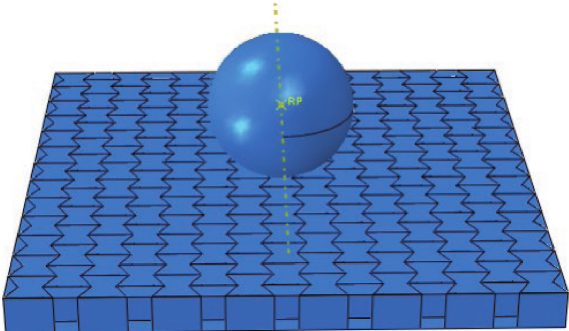
Figure 7: FE model of the FGH sandwich plate under impact.